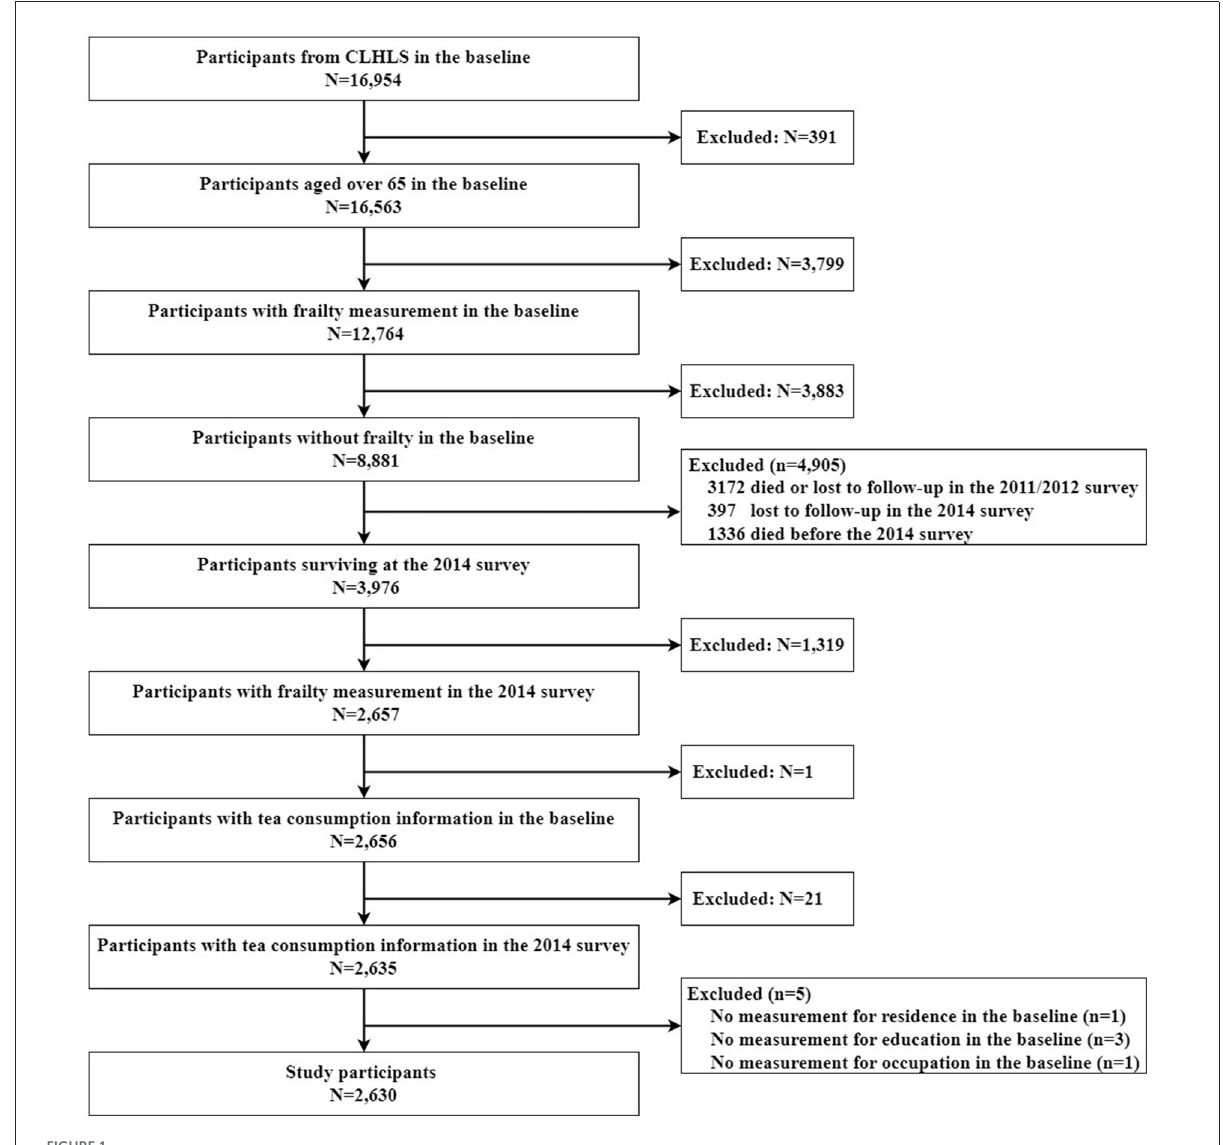
FIGURE1 Flow chart of sample